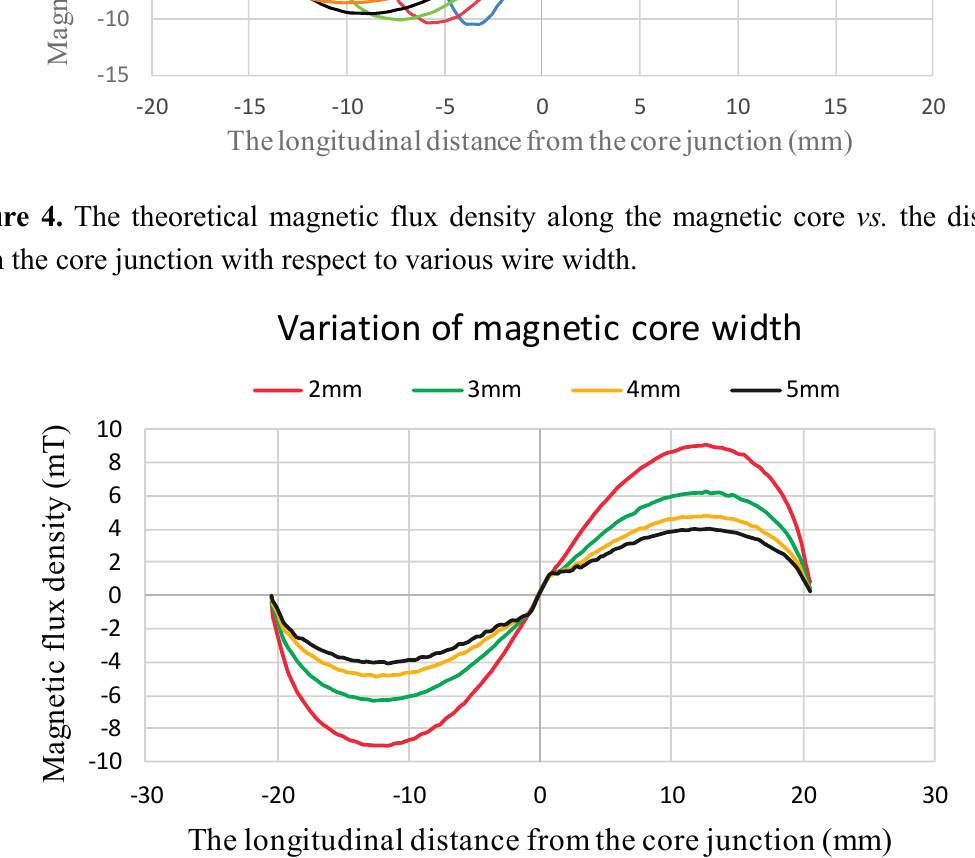
Figure 5. The theoretical magnetic flux density along the longitudinal core vs. the distance from the core junction with respect to various core